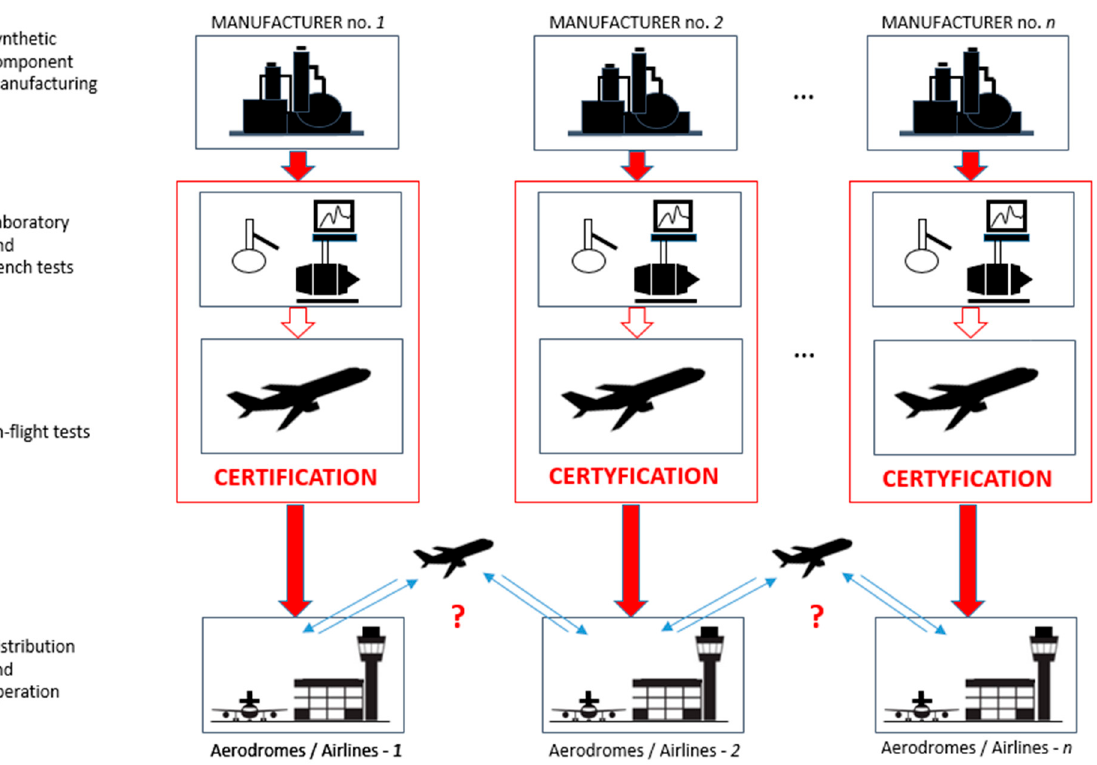
Figure 1. Diagram of certification tests for fuels containing synthetic components.